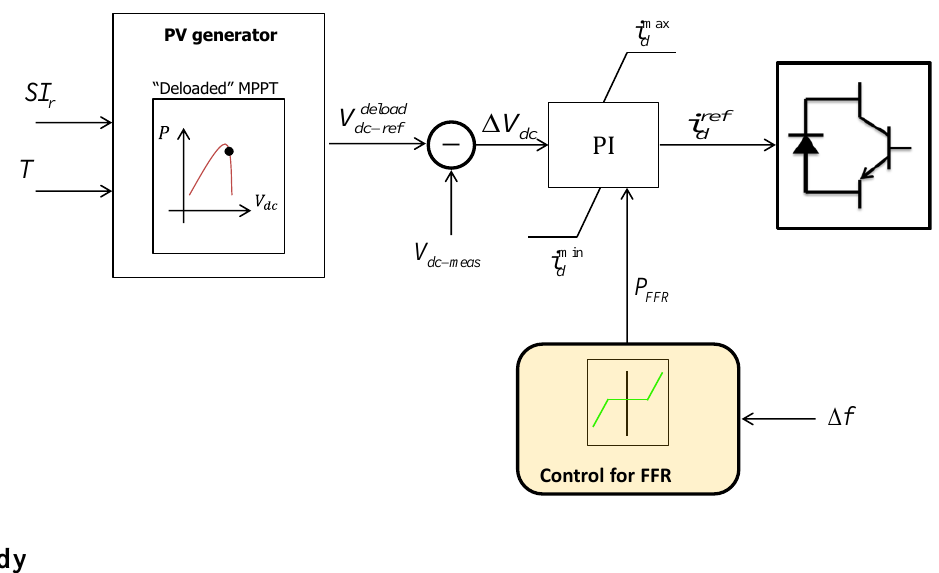
Figure 3. Control scheme for fast frequency response (FFR) in